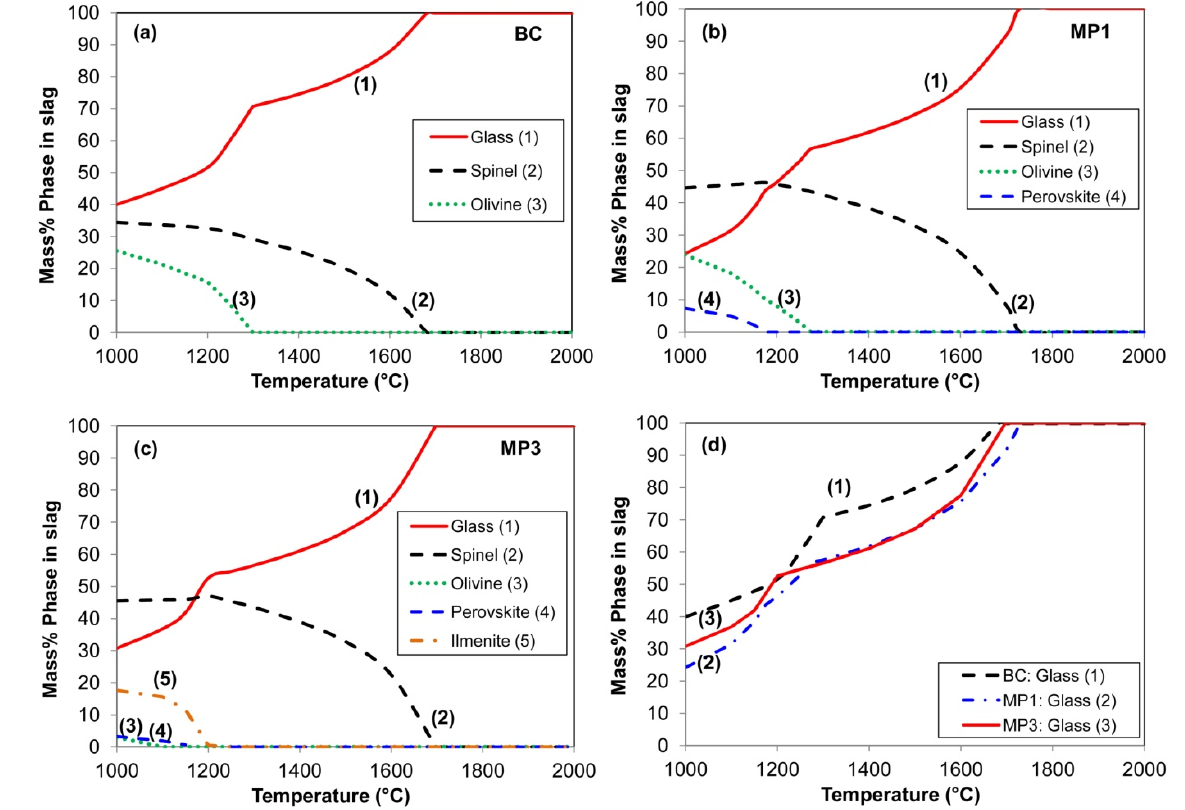
Figure 7. ( a – d ) Solidification curves for post-weld slags as calculated in FactSage 7.3 [40,41].